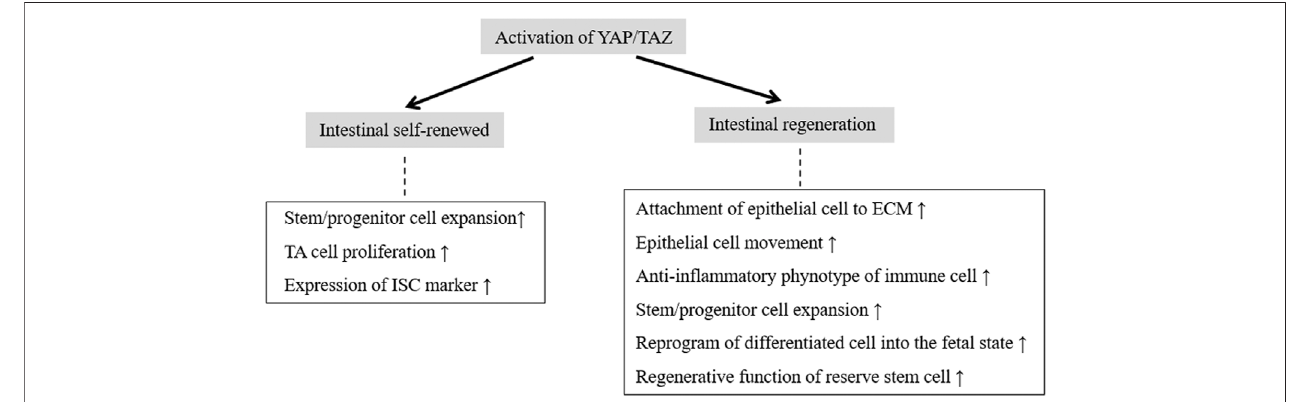
FIGURE 4 | The roles of YAP/TAZ activation in intestinal self-renewal and